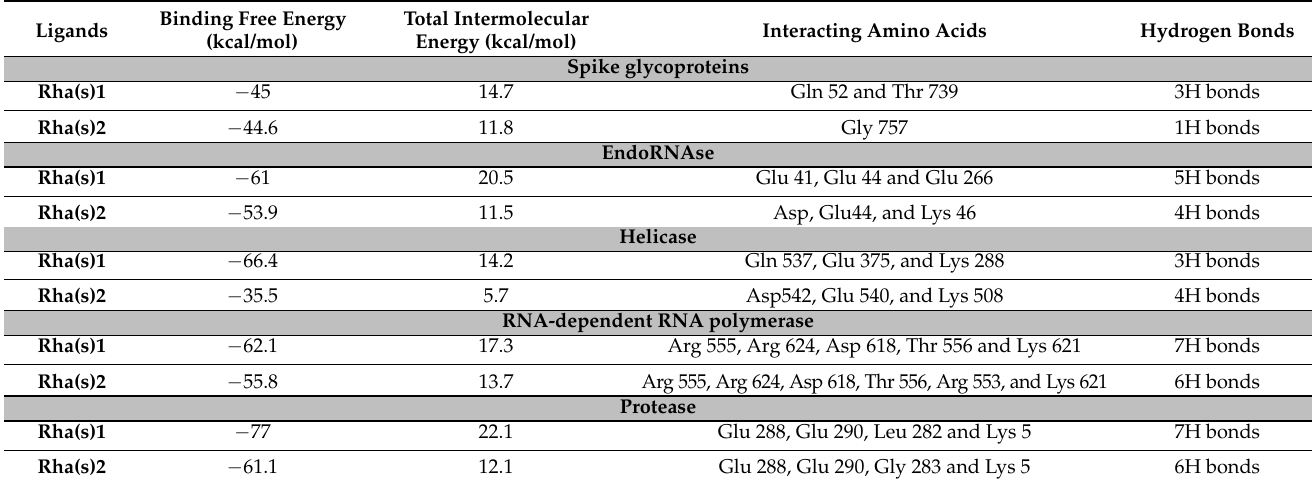
Table 4. The docking interaction parameters of both Rha(s)1 and Rha(s)2 with spike glycoproteins of SARS-CoV-2 and enzymes involved in viral replication: EndoRNAse, helicase, RNA-dependent RNA polymerase and protease. Binding Free Energy Total Intermolecular Ligands Interacting Amino Acids (kcal/mol) Energy (kcal/mol)